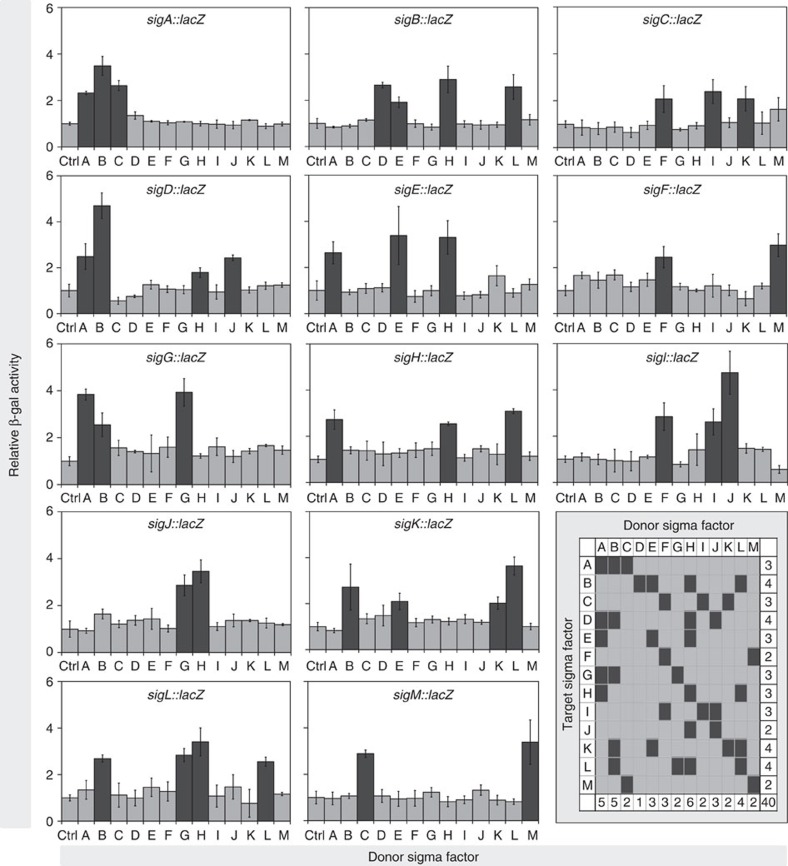
β-galactosidase assay results for the 13 × 13 matrix of
M. tuberculosis
sigma factors.E. coli strains containing all pairs in the 13 × 13 matrix were used for β-galactosidase assays performed using the medium-throughput protocol (Methods). Each panel shows results for a single target sig::lacZ fusion tested against each of 13 sigma factor donor plasmids, plus the empty donor plasmid (control plasmid, Ctrl). Data were expressed as Miller units (MU), as described in Methods. Relative β-galactosidase activity was calculated as . Data are presented as mean values (±s.d.) from triplicate experiments. Black bars represent significant interactions (P<0.05, tested by ANOVA). The last panel represents a summary of the interaction data between target sigma factors (rows) and donor sigma factors (columns). Black boxes at the intersection between rows and columns represent interactions of the corresponding sigma pair. Each black box matches a black bar in the panel of the corresponding target sigma factor. The last column and row in the margins of the summary matrix represent the total number of interactions in the corresponding row (target sigma) and column (donor sigma), for a grand total of 40 (bottom right-corner box).